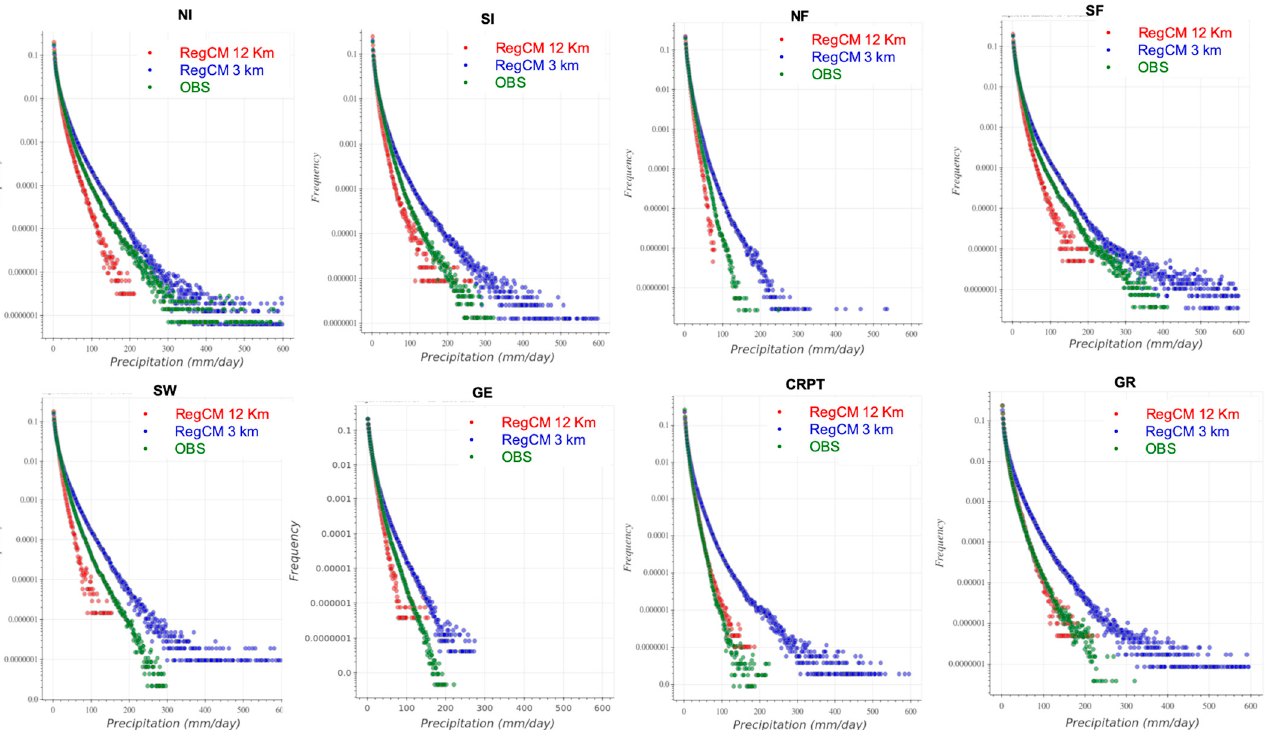
Figure 13. Probability density function (PDF) of daily precipitation over North and South Italy (NI, SI), North and South France (NF, SF), Switzerland (SW), Germany (GE), the Carpathians (CRPT), and Greece (GR). CP-RCM simulation at 3 km is in blue, RCM at 12 km is in red, and observations are in green. GRIPHO dataset has been used for Italy; COMEPHORE for France; RdisaggH for Switzerland; RADKLIM for Germany; and the ensemble mean of HMR, PERSIANN, CHIRPS, and CMORPH for the Carpathians and Greece.